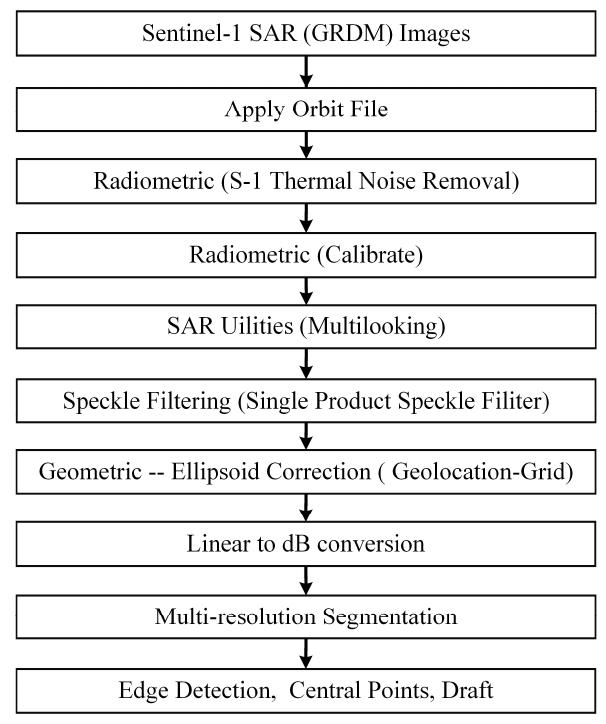
Figure 1. RIS rift measurements before calving and iceberg tracking after calving.